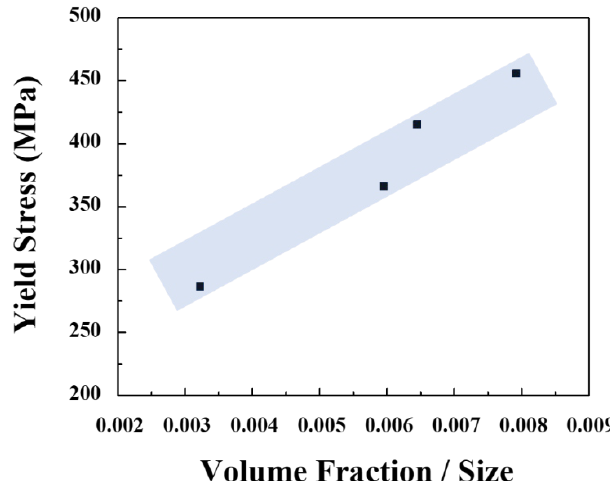
Figure 9. Schematic illustration of the relation between the yield stress and ratio of precipitation volume fraction to precipitation size.